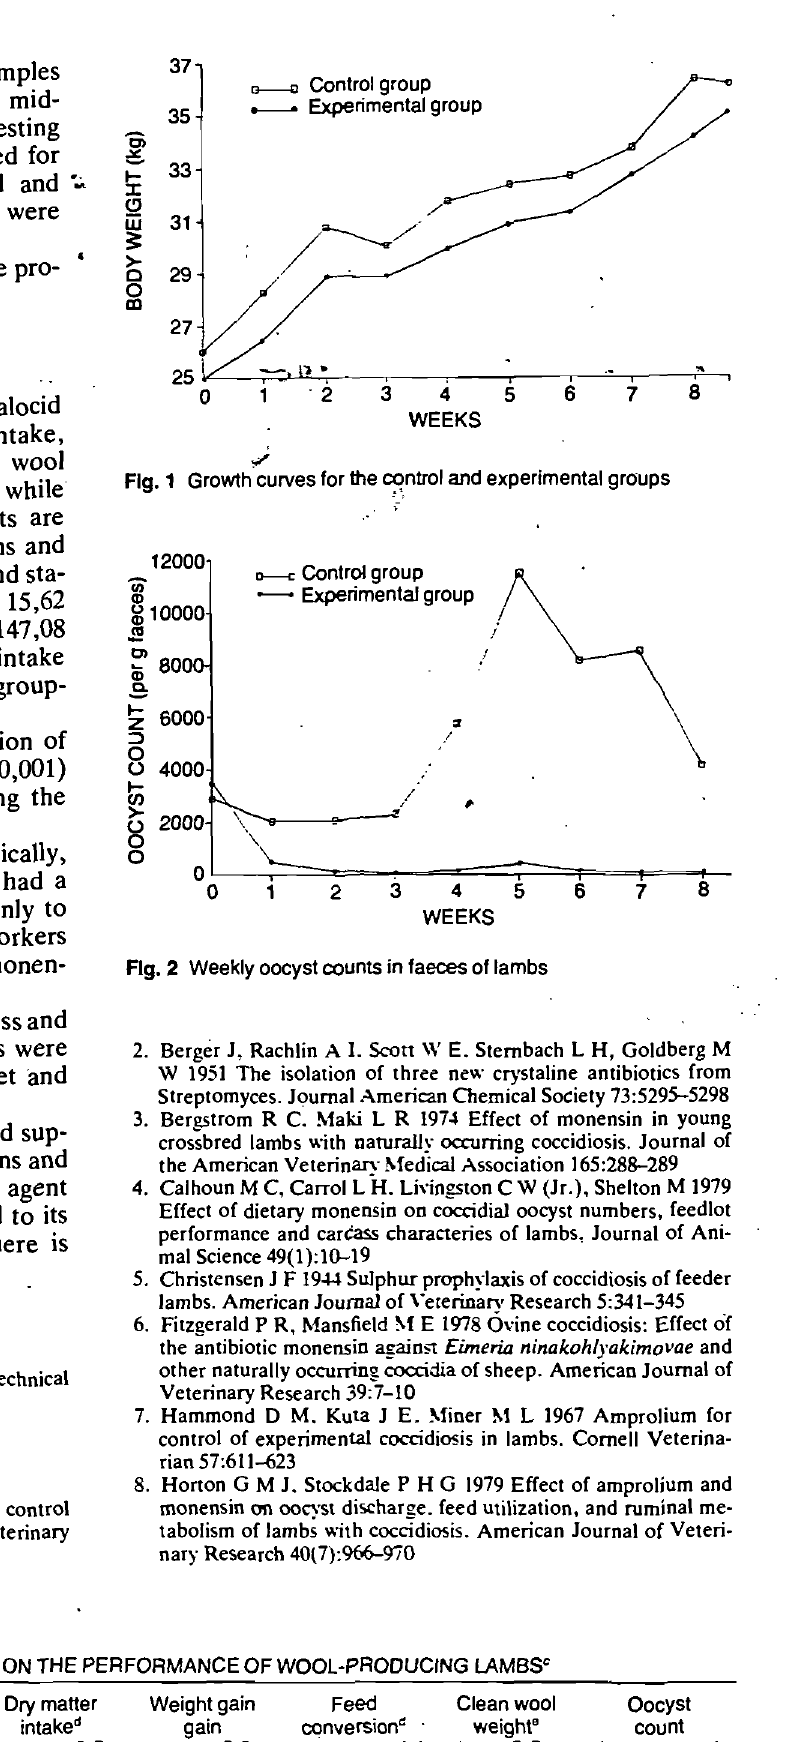
Table 2: THE EFFECT OF LASALOCIO ON THE PERFORMANCE OF WOOL-PRODUCING LAMBSc Number of • Initial Dry matter Weight gain Feed Clean wool